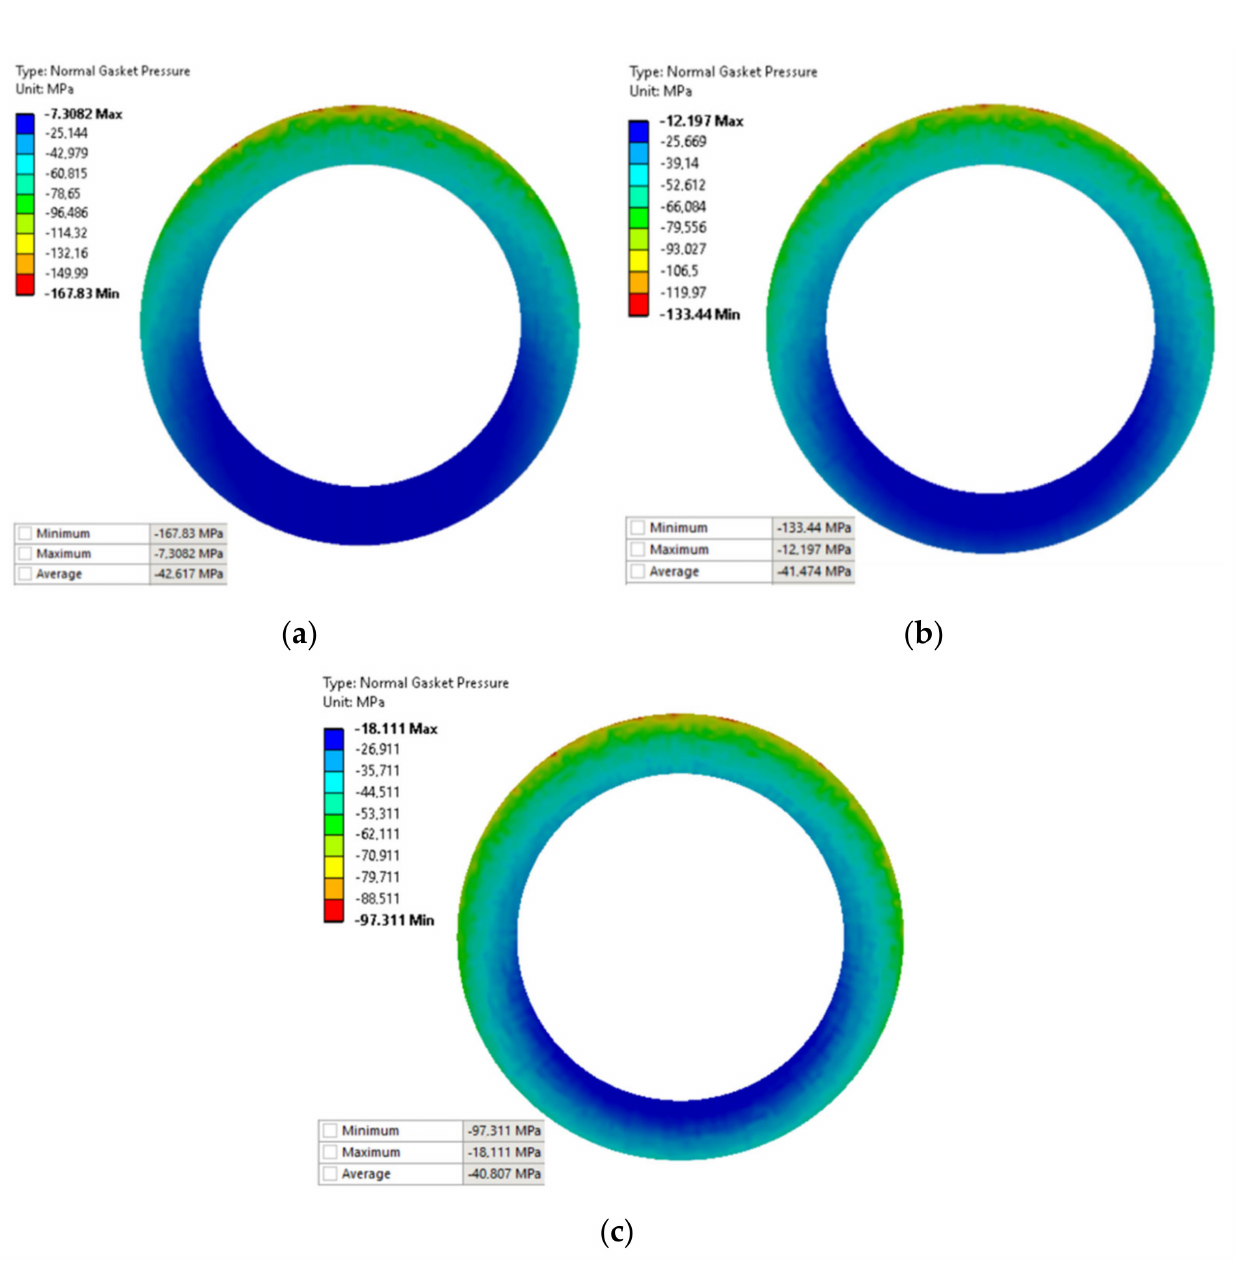
Figure 17. Pressure distribution on the surface of the gasket due to the deflection of the pipeline by: ( a ) 1.2 mm, ( b ) 0.8 mm, and ( c ) 0.4